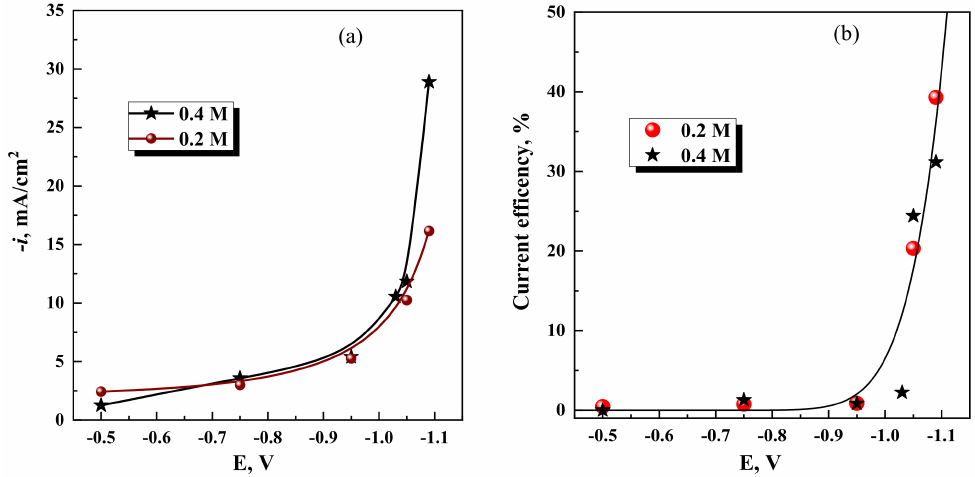
Figure 3. Influence of electrode potential on current density ( a ), and current efficiency for Fe-W electrodeposition ( b ) at various Na 2 WO 4 concentrations on the stationary Cu